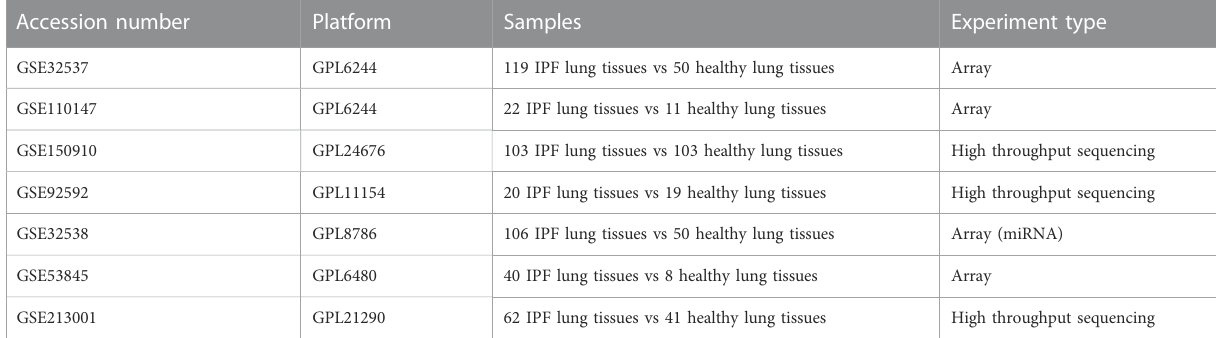
TABLE 1 Details of all the GEO datasets used in this